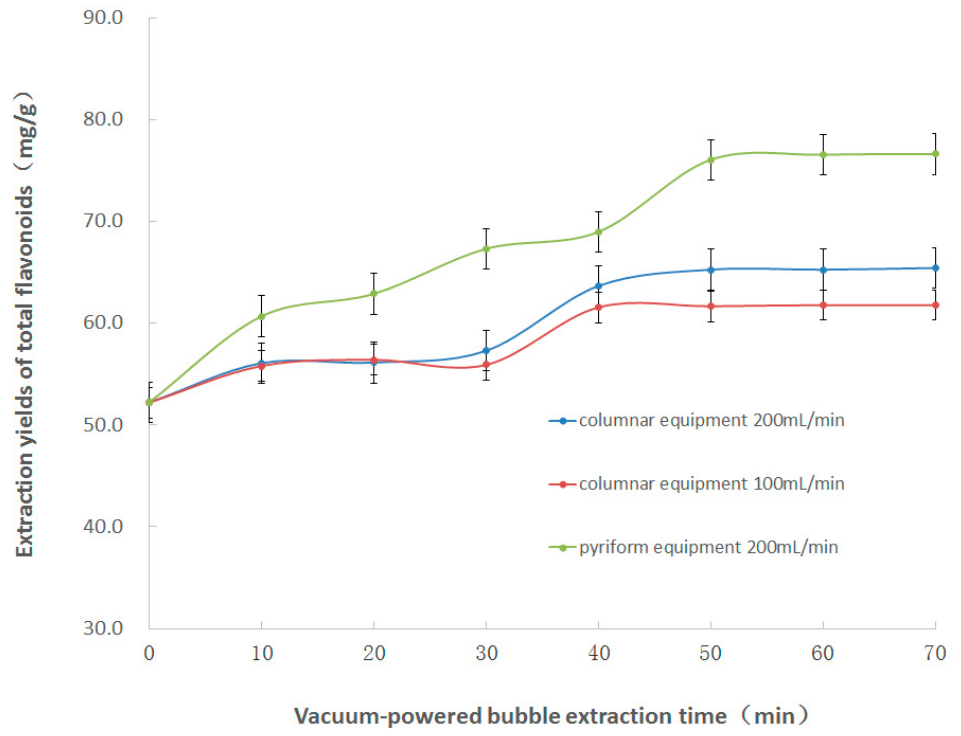
Figure 2. Effect of the extraction time on the vacuum-powered bubble extraction.